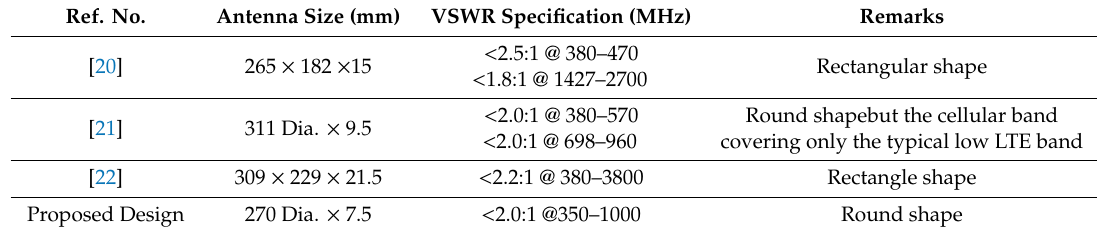
Table 2. Commercial ULP \ low profile DAS antenna products that for converged PS \ PPDR and LTE Cellular. Ref.